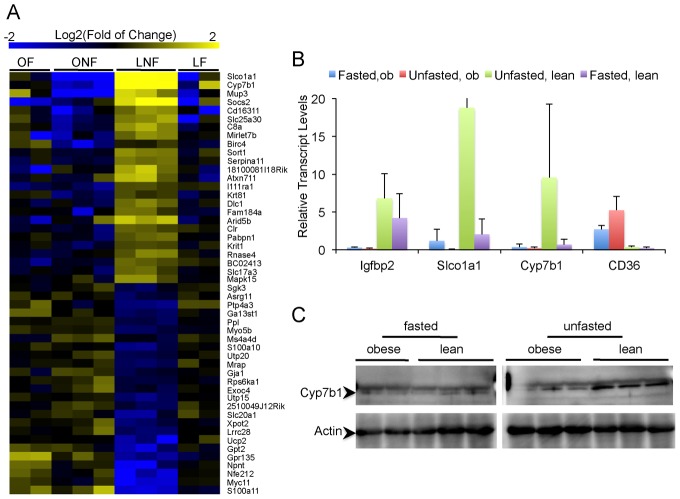
Dysregulation of bile acid metabolism in the obese ER translatome.(A) Heatmap of 50 most differentially regulated genes in the obese ER-associated translatome (25 up, 25 down) that are also suppressed in the lean fasted liver. ONF: obese non-fasted, LNF: lean non-fasted, OF: obese overnight-fasted, LF: lean fasted. Fold changes are calculated based on the mean of all ten samples. (B) Validation of feeding-induced upregulation of Cyp7b1 and Slco1a1, but not CD36 and Igfbp2, in the translatome of lean mouse liver. (C) Western blot of Cyp7b1 from the liver of lean and obese mice with or without overnight fasting.